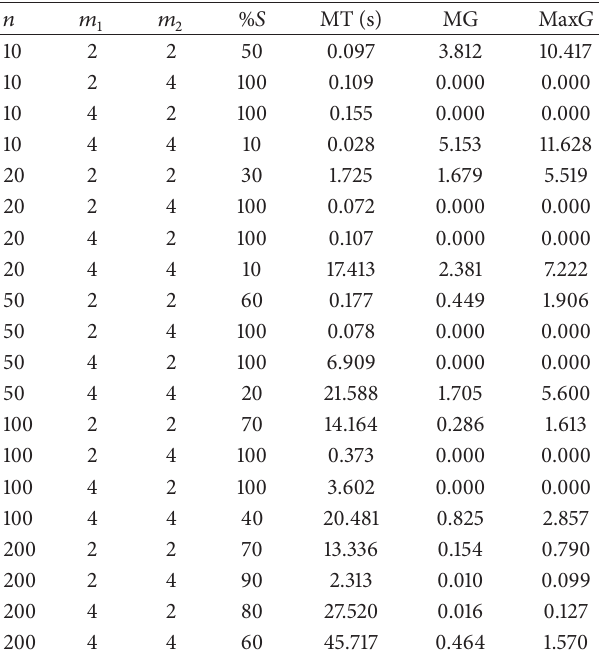
Table 4: Performance for 𝑎 = 𝑐 = 20 and 𝑏 = 𝑑 = 40